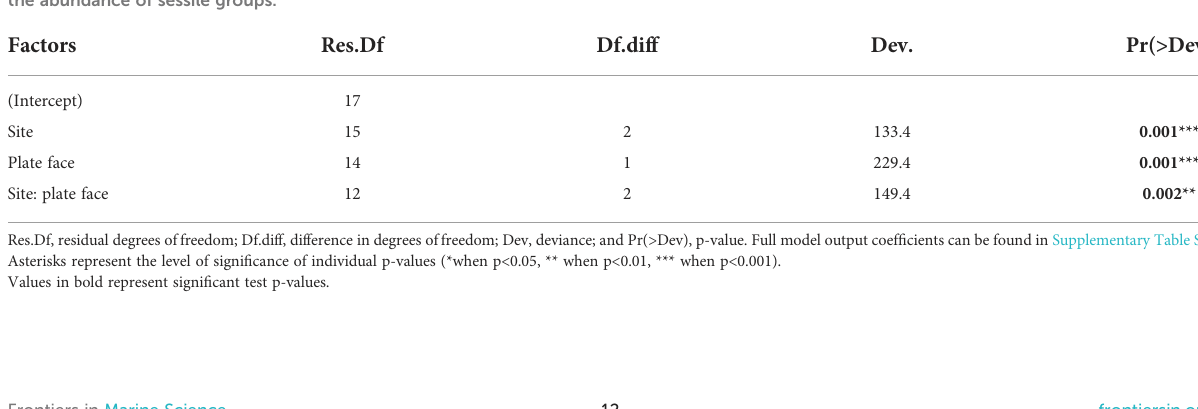
TABLE 1 Summary of the statistical signi fi cance of a multivariate generalised linear models (GLMs) assessing the effect of site and plate face on the abundance of sessile groups. Factors Res.Df Df.diff Dev. Pr(>Dev)